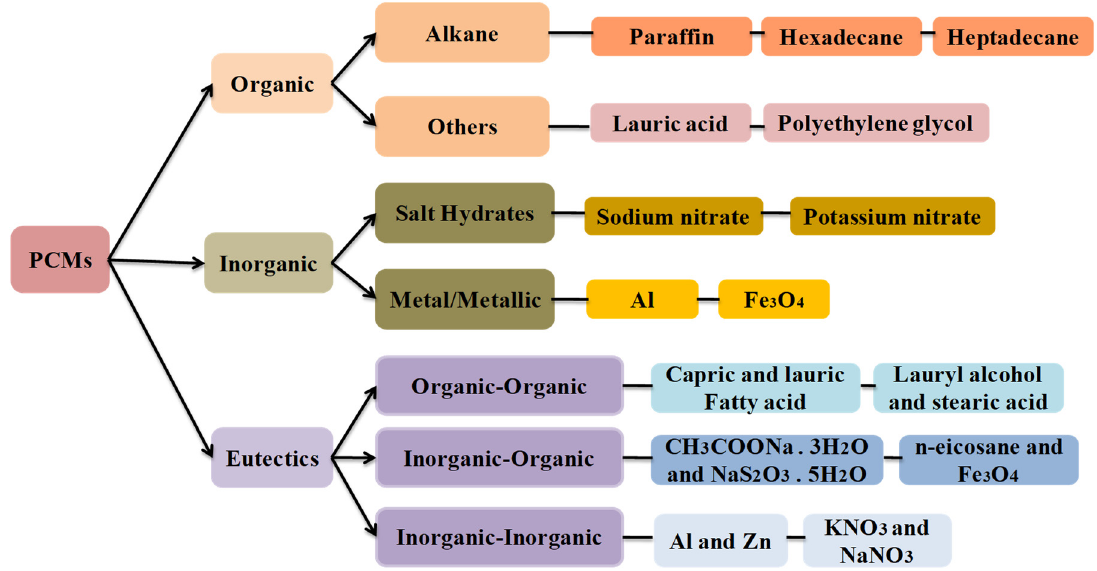
Figure 11. PCMs’ subdivision based on phase transition [3,20,24,75–77], reprinted/adapted with permission from Refs. [20,24,75], 2022, Elsevier. Table 5. Benefits and drawbacks of PCMs based on their classification [24,77].